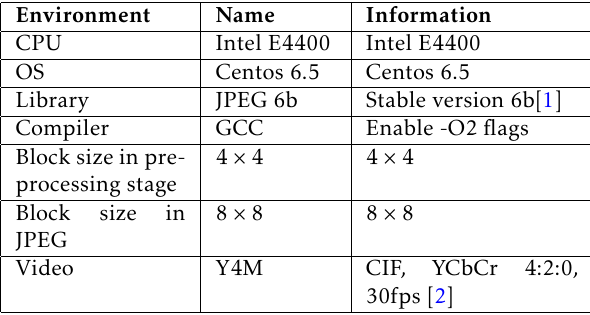
Figure 11. Percentage of motion. Table 2. Testing environment